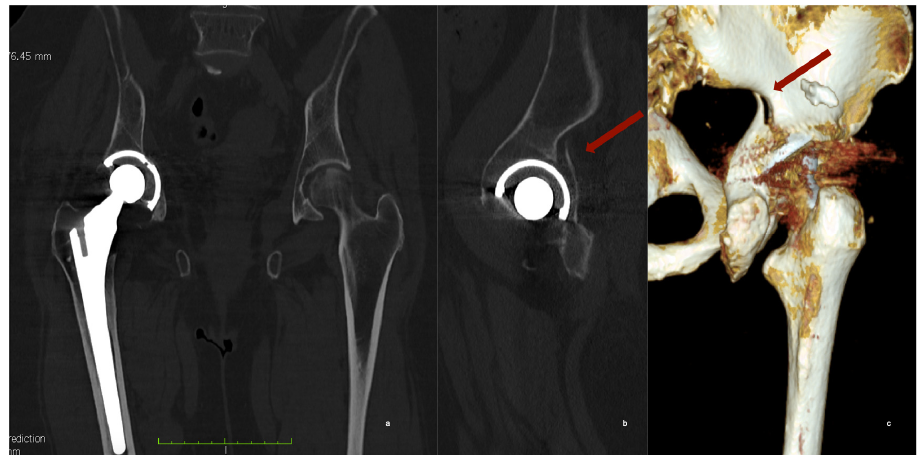
Figure 2. CT scan of the pelvis. ( a ) Coronal view shows a slightly medially protruded acetabular cup; ( b ) the sagittal view of the hip, revealed the posterior wall fracture of the acetabulum and ( c ) in the tridimensional reconstruction the fracture is clearly visible, but its extension is hidden by image artifacts.